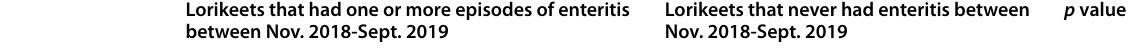
Table 1 Columbus Zoo and Aquarium (CZA) Lorikeet Demographics. Number and percent of Columbus Zoo & Aquarium lorikeets that ever or never had enteritis between Nov. 2018 and Sept. 2019 by sex, age, and lorikeet species Lorikeets that had one or more episodes of enteritis Lorikeets that never had enteritis between between Nov. 2018-Sept. 2019 Nov. 2018-Sept.